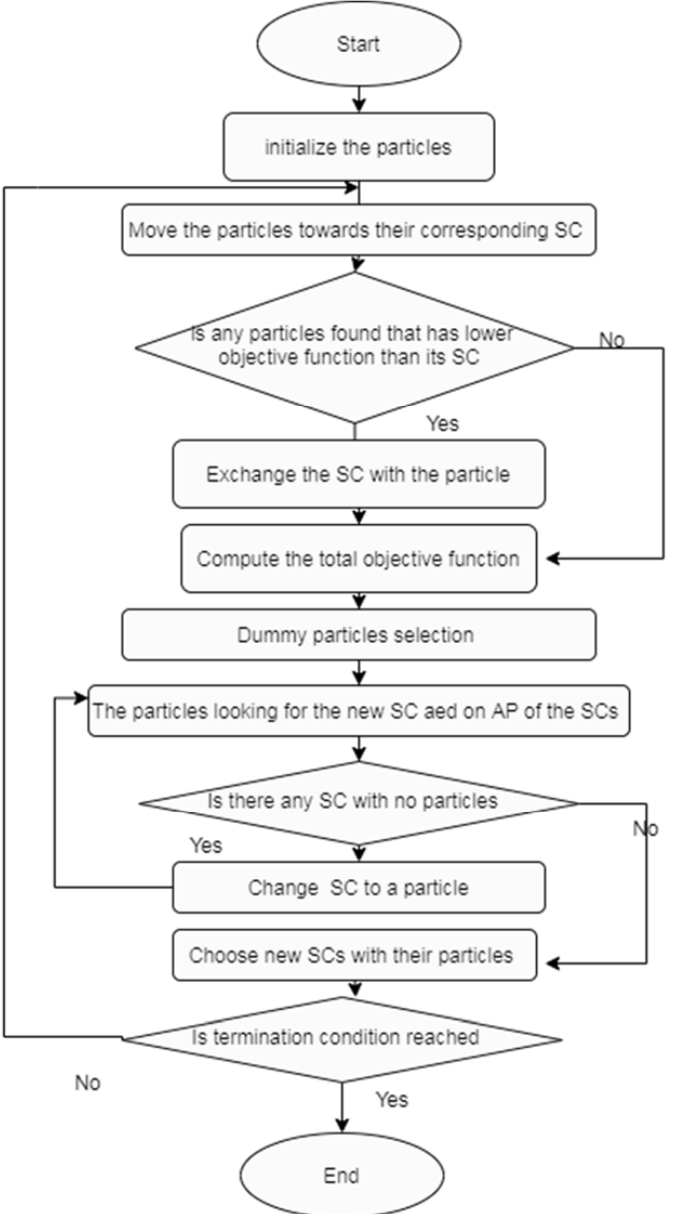
Figure A4. HSSA flow Figure B3. HSSA flow chart.